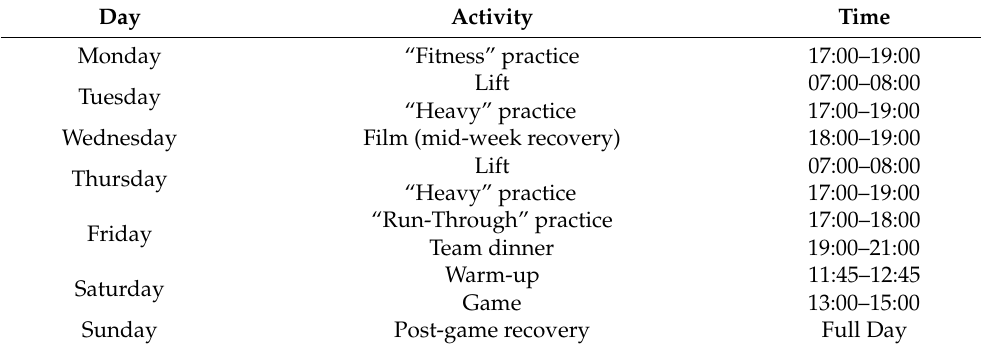
Table 2. Women’s varsity rugby team weekly